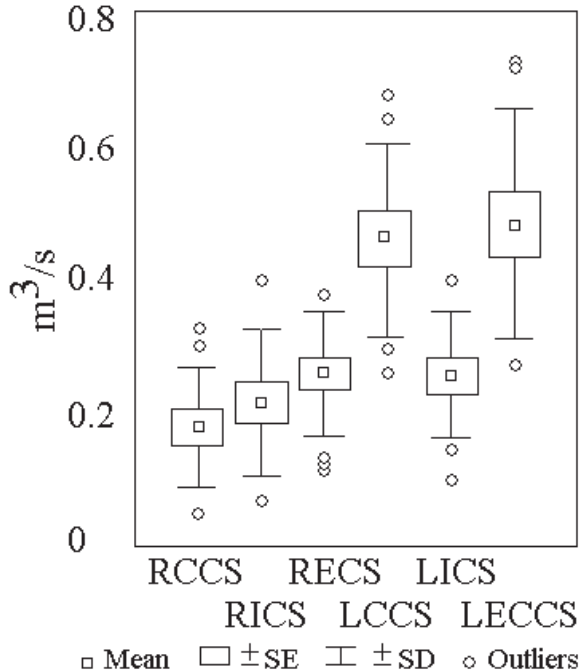
Fig. 5. Water velocities in right and left collection channels of the Yacyreta fish passage system. RCCS: Right crowder chan- nel section; RICS: right intermediate channel section; RECD: right entrance channel section; LCCS: left crowder channel section; LICS: left intermediate channel section; LECS: left entrance channel